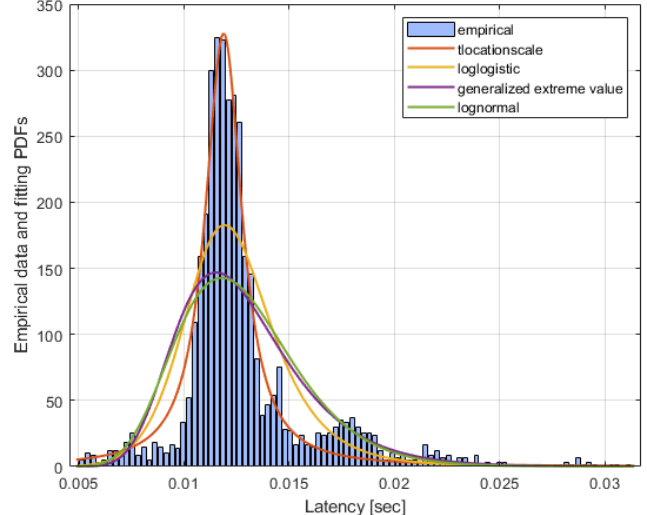
Figure 8. Empirical distribution of the latency of the overall system (5G link and VLC link) and PDFs of the fitting distributions.